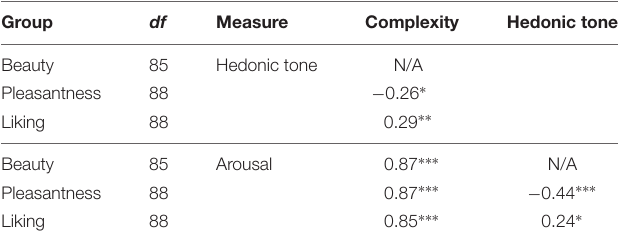
TABLE 9 | Partial Spearman’s rank order correlations controlling for familiarity between measures of complexity, arousal and hedonic tone in response to 19th-century piano solo